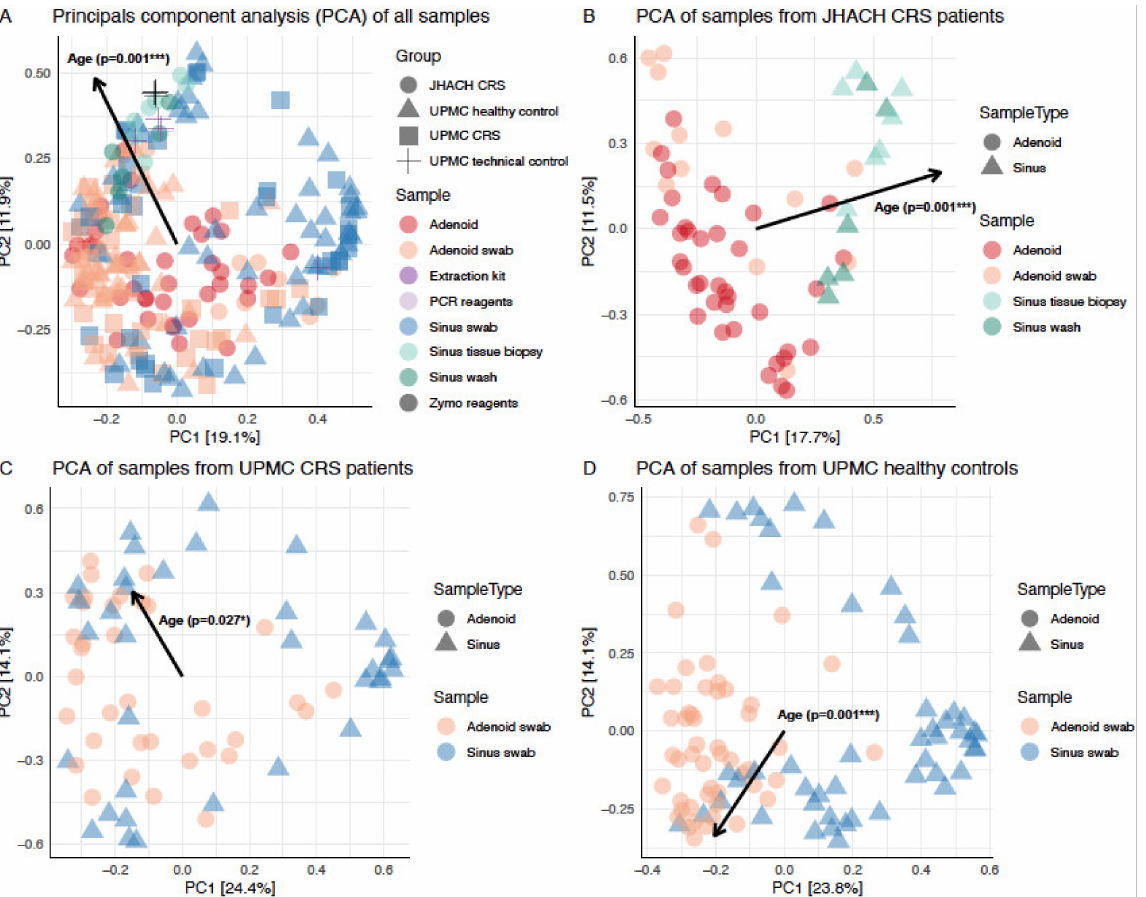
Figure 3. Principal components analysis (PCA) biplot showing the significant effects of age on the clustering of ( A ) all analyzed samples; ( B ) samples collected from chronic rhinosinusitis (CRS) patients in the Johns Hopkins All Children’s Hospital (JHACH) cohort; ( C ) samples collected from CRS patients in the University of Pittsburgh Medical Center (UPMC) cohort; and ( D ) samples collected from healthy controls in the UPMC cohort. Each point in the PCA biplot represents a sample. The percentages on each axis represent the relative contribution (eigenvalue) of each axis to the total inertia (variation) in the dataset. * denotes a p -value of ≤ 0.05 and *** denotes a p -value of ≤